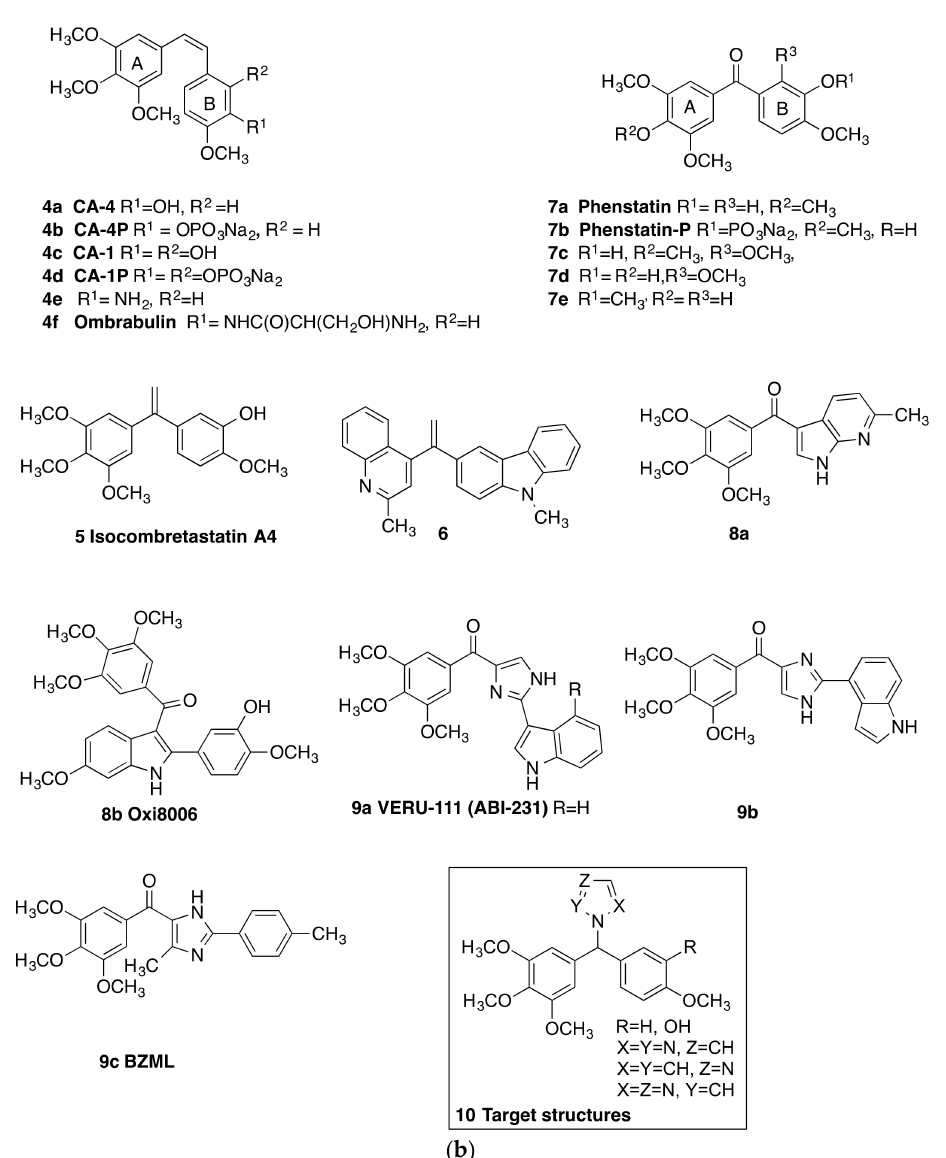
Figure 1. ( a ) Aromatase inhibitors (letrozole, anastrozole, Exemestane), SERMs (Tamoxifen, Endoxifen, Norendoxifen, Raloxifene), kinase inhibitors Lapatinib, Alpelisib, Tucatinib, steroid sulfatase inhibitor Irosustat and mutant p53 inhibitor PRIMA-1, ( b ) Combretastatins 4a–f , Isocombretastatins 5 , 6 , phenstatins 7a–e, colchicine binding site inhibitors 8a , b , 9a–c and target structures 10